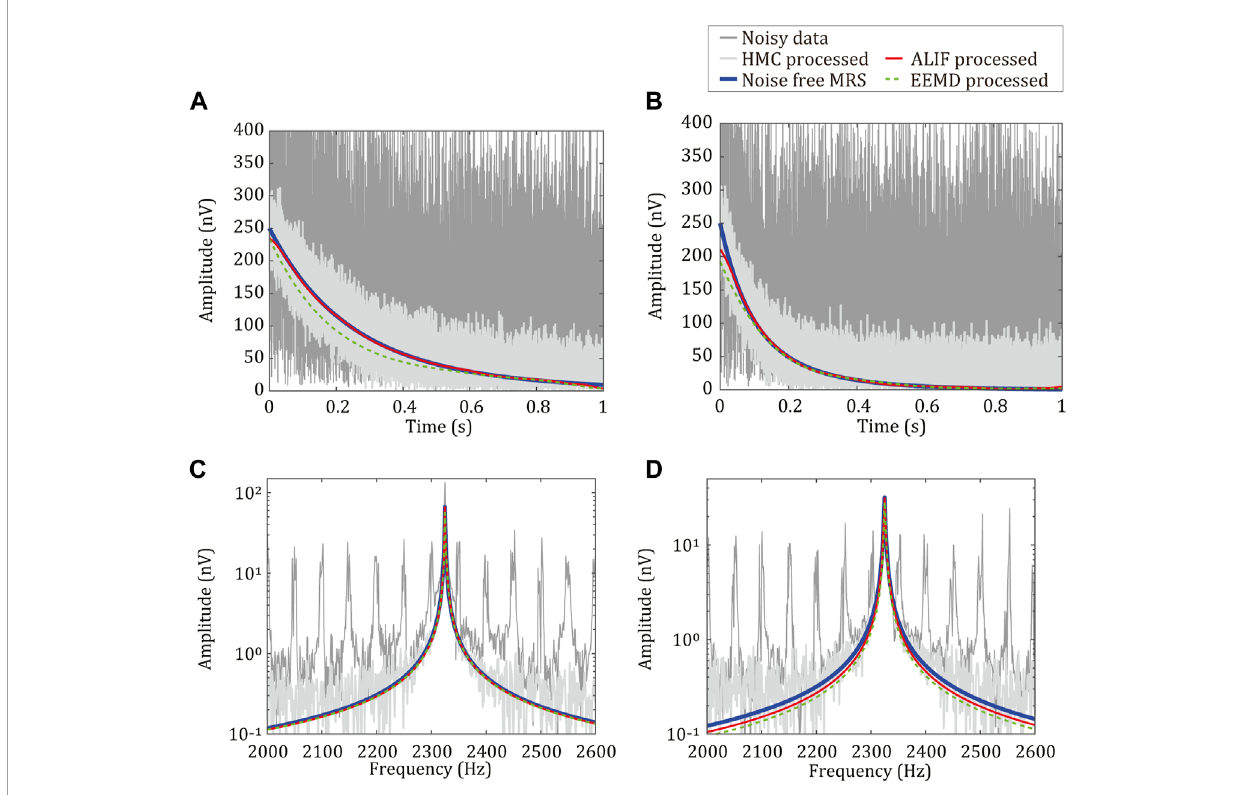
FIGURE 8 Time domain and frequency domain diagrams of multi-exponential noisy MRS datas processed by ALIF algorithm, EEMD algorithm, and HMC. In (A) and (C) , T